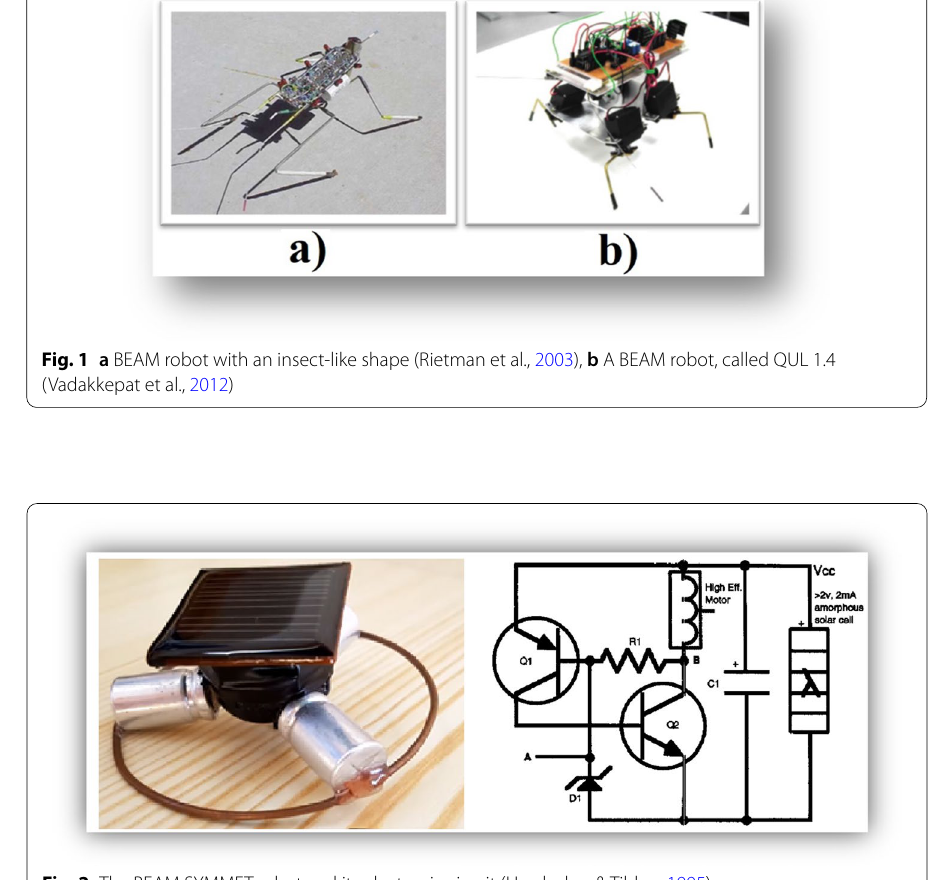
Fig. 2 The BEAM SYMMET robot and its electronic circuit (Hasslacher & Tilden,